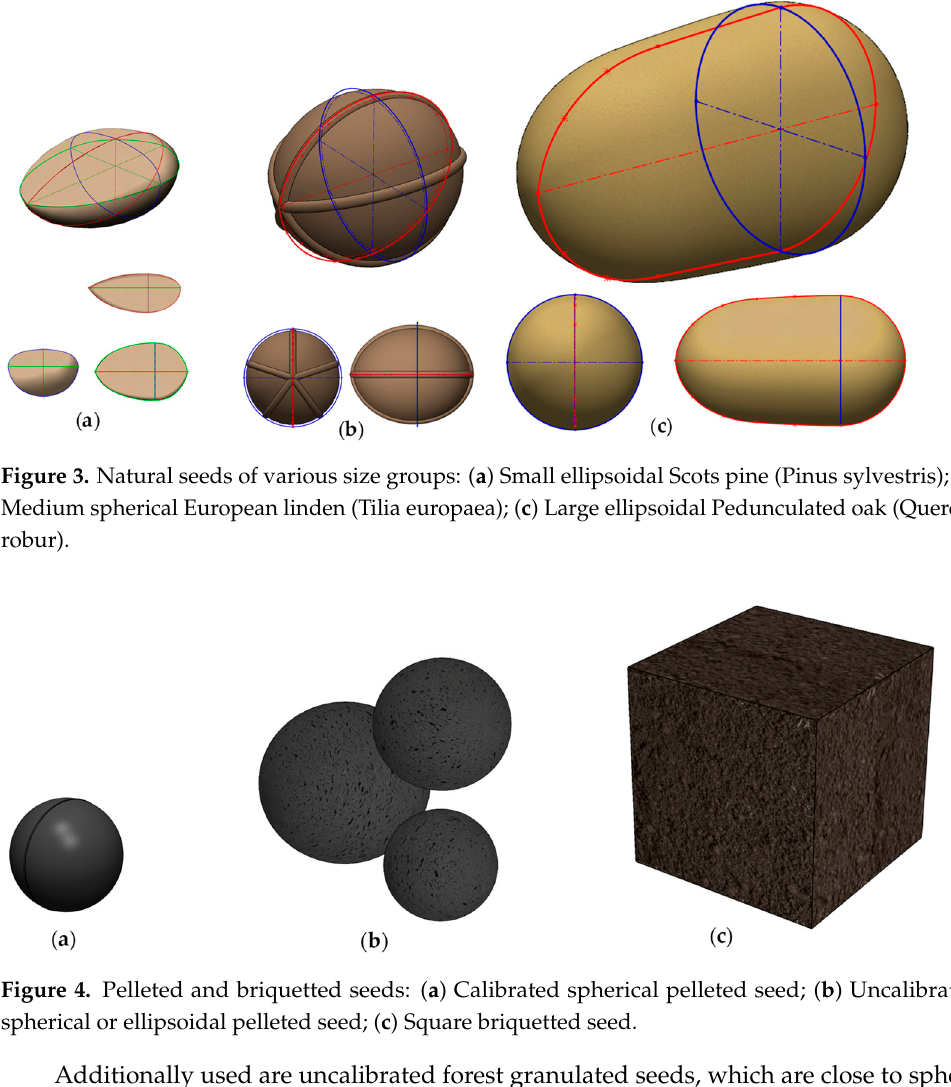
Figure 4. Pelleted and briquetted seeds: ( a ) Calibrated spherical pelleted seed; ( b ) Uncalibrated spherical or ellipsoidal pelleted seed; ( c ) Square briquetted seed.